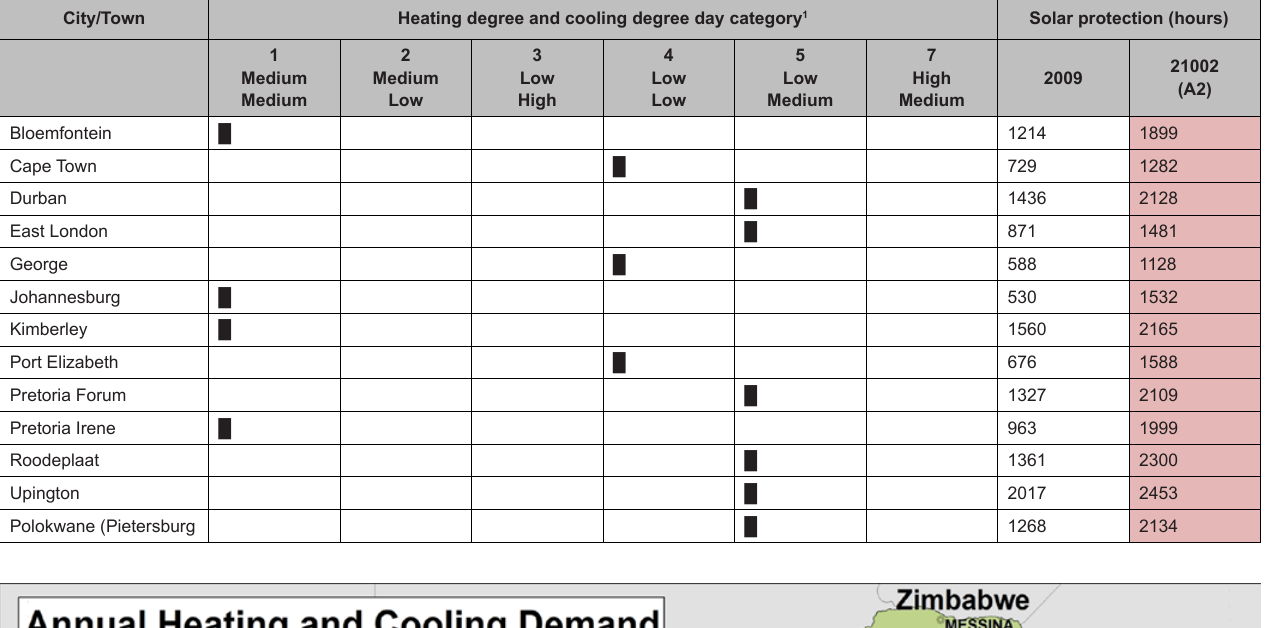
Table 1: Quantified benefit of solar protection benefit for various cities and towns in various climatic regions with and without climate change